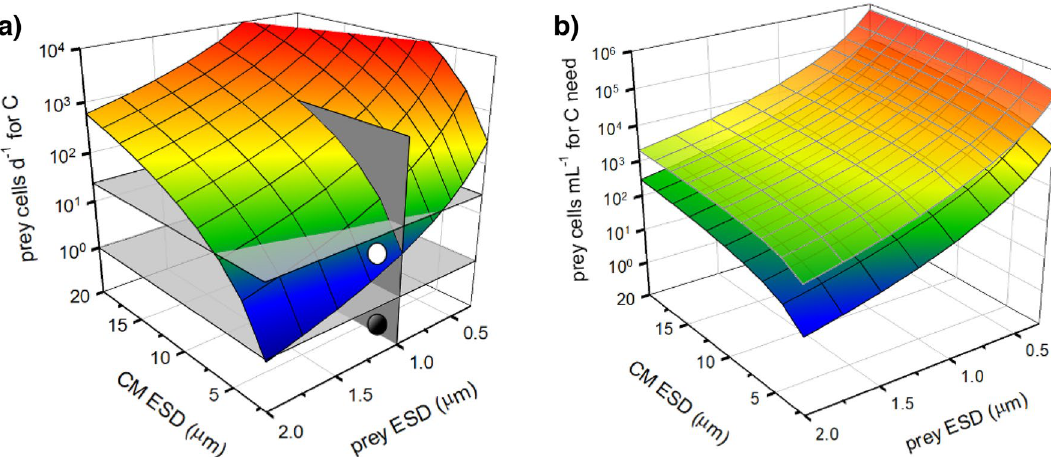
Figure 2. Assimilation rates of prokaryote picophytoplankton prey cells per mixoplankton cell required to satisfy C structural needs for the replication of mixoplankton cells of different sizes. In Panel ( a ), the horizontal plane at 10 0 is for an ingestion rate of 1 prey d −1 ; a mesh in the zone below this plane (dark circle) indicates that fewer than one ingestion event per day would satisfy the demand. The horizontal plane at 10 1.38 indicates an ingestion rate of 24 prey d −1 (i.e., an average of 1 prey h −1 ); the mesh in the zone between this plane and the lower plane (white circle) indicates that ingestion events between 1 and 24 prey d −1 would satisfy demand. Panel ( b ) shows the prey abundance required to support the grazing rates in panel ( a ) assuming ingestion of all encountered prey under conditions of no turbulence (upper mesh), and with turbulence (1e-3 m s −1 ; lower mesh). ESD, equivalent spherical diameter. See Table S1 for stoichiometric values.